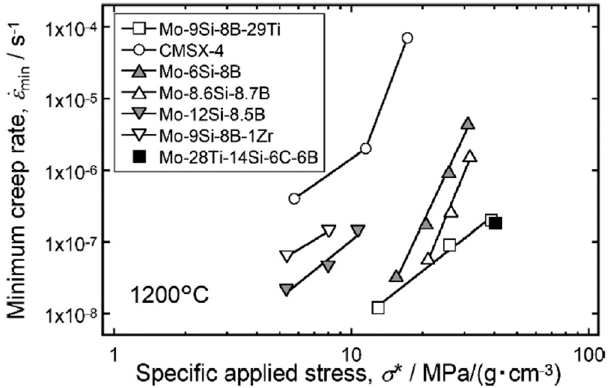
Figure 12. Double logarithmic plot of the minimum creep rate against applied stress at 1200 °C and 300 MPa of Mo–Ti–Si–B-based alloys compared with those of other Mo–Si–B alloys and the single-crystalline Ni-based superalloy CMSX − 4 [34].